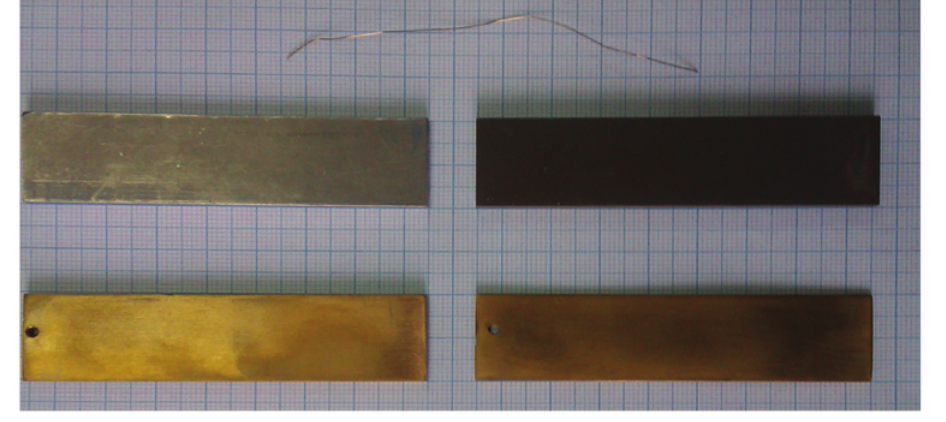
Figure 4 Ti-6Al-4V alloy and brass wire.